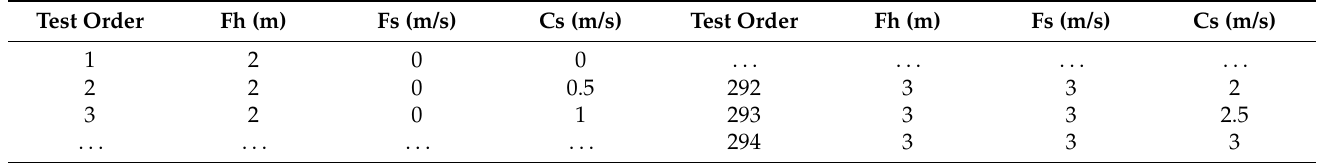
Table 2. 294 combinations of experiment parameters.